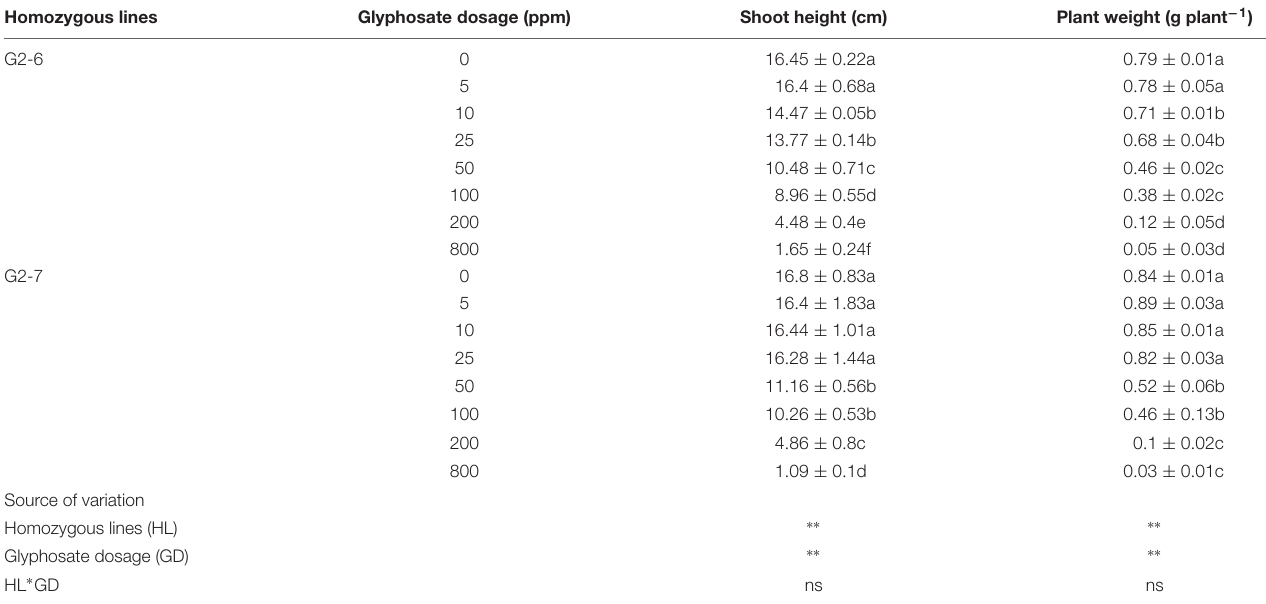
TABLE 3 | Agronomic performances of the selected transgenic lines under different glyphosate treatments. Homozygous